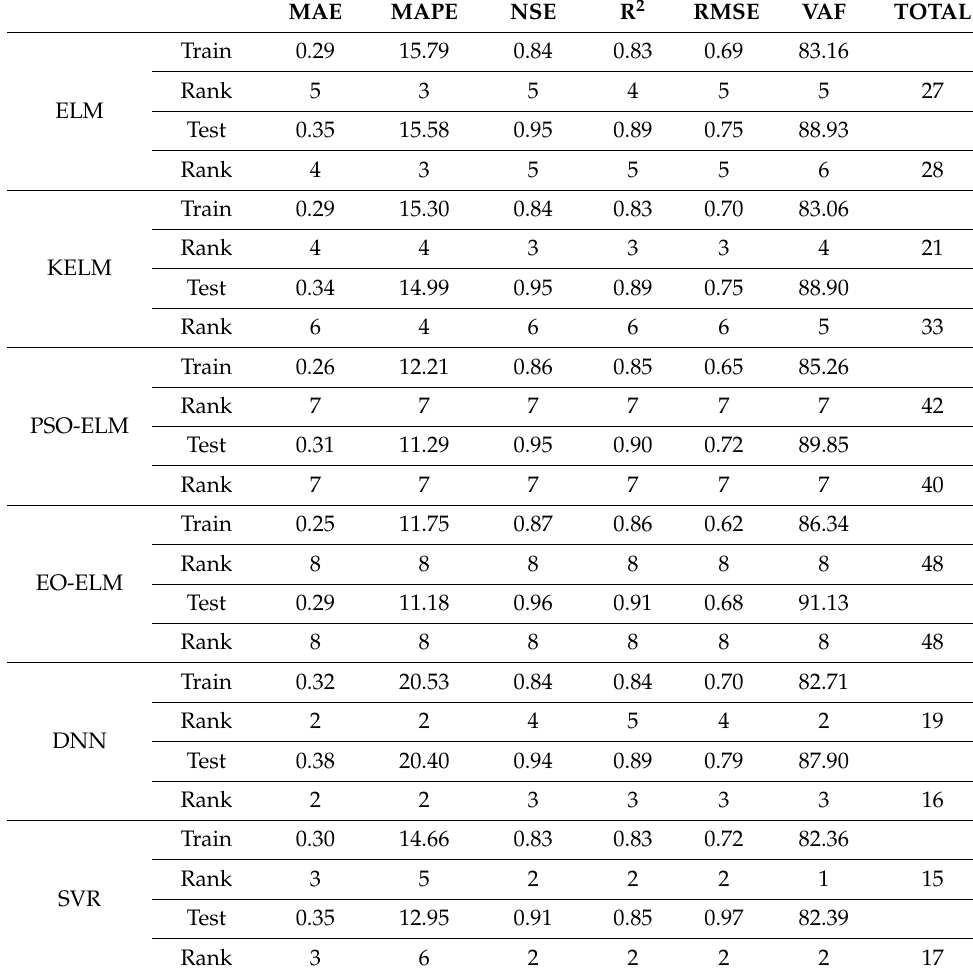
Table 3. Lag-based models’ performance evaluation of the catchment Fal at Tregony.